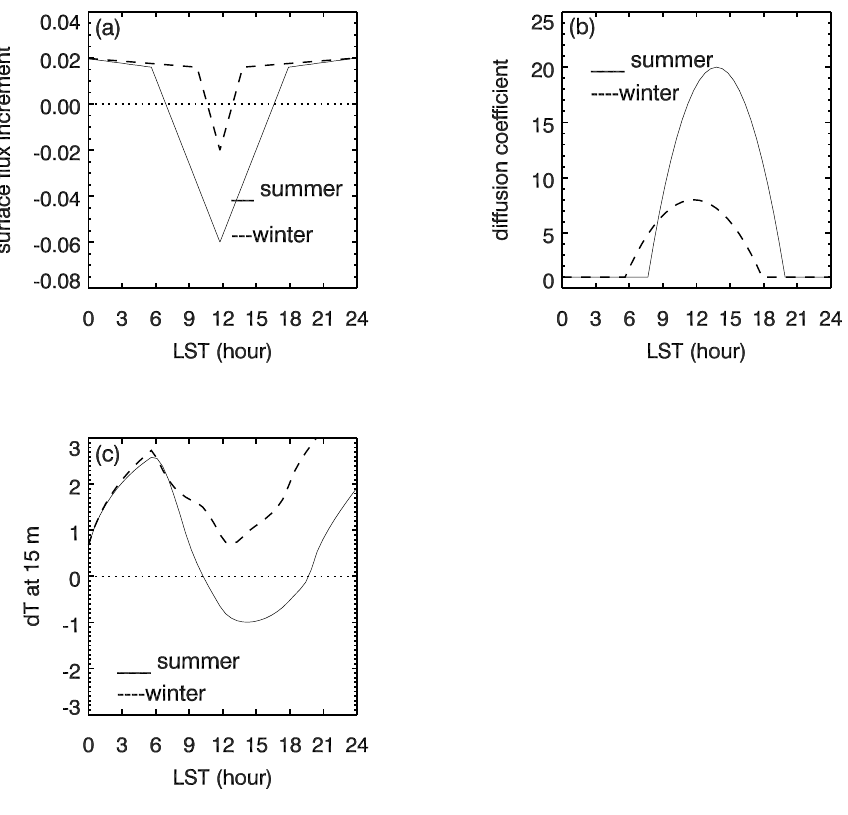
Figure 3. Diurnal variation of ∆ J ( a ), reference diffusion coefficient ( b ) and diurnal temperature response to ∆ J at 15 m ( c ) in the summer case (solid lines) and winter case (dashed lines).